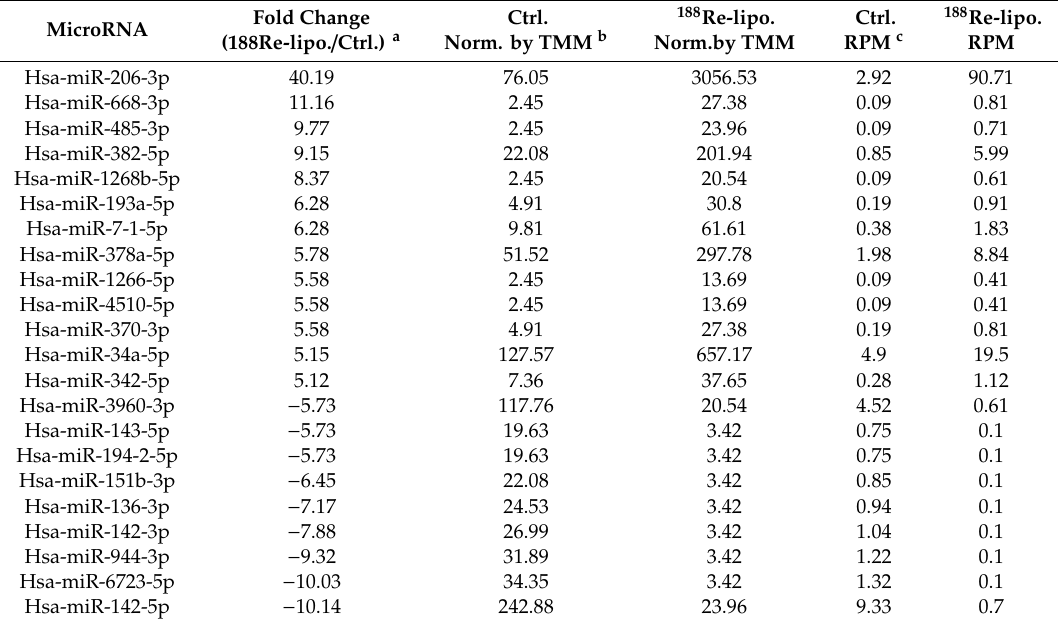
Table 1. Expression of microRNAs in human hypopharyngeal tumor model treated with 188Re-liposome. Fold Change MicroRNA (188Re-lipo. / Ctrl.)